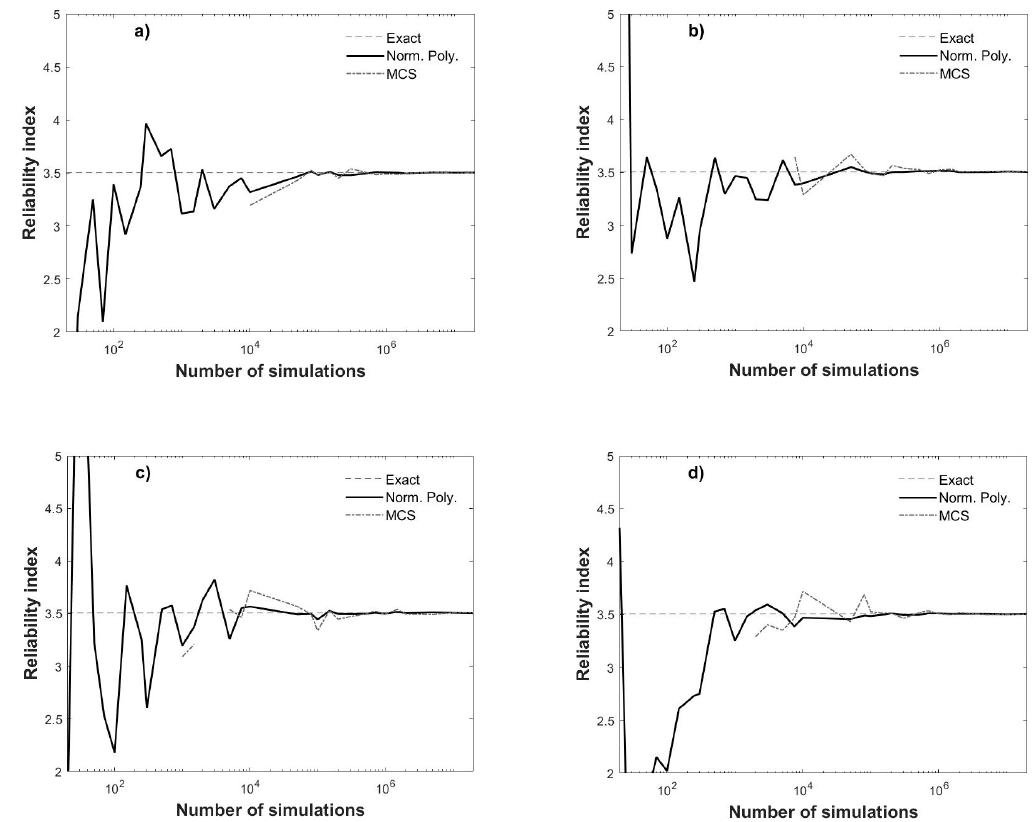
Figure 1. Reliability index as a function of the number of simulations. ( a ), ( b ), ( c ) and ( d ) are different runs for the MCS.